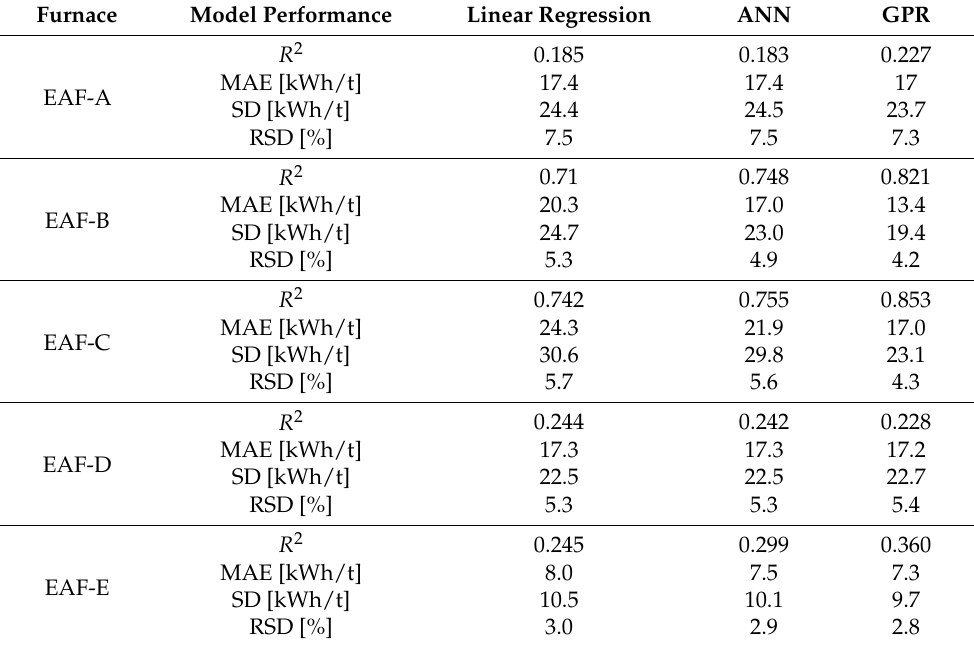
Table 6. Median results for regression on the data available before finishing of the